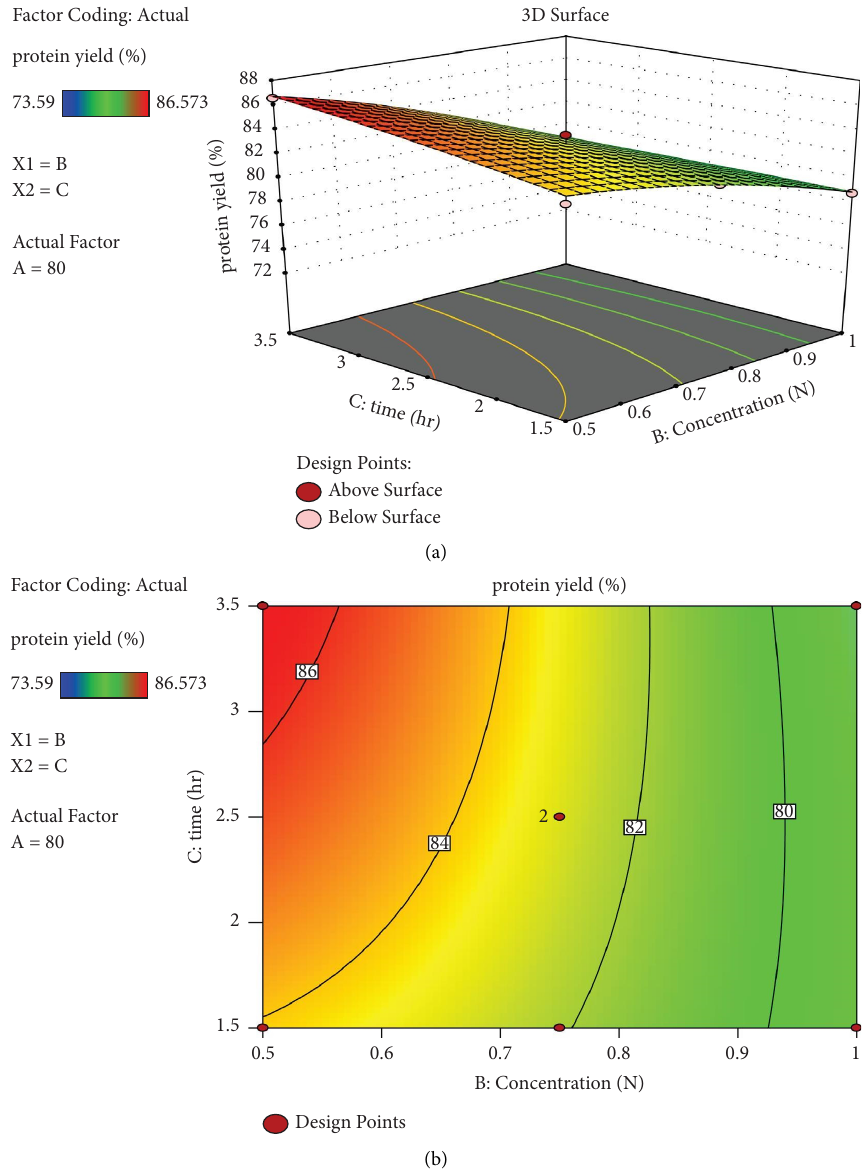
Figure 11: (a) 3D interaction efect time and concentration (b) contour plot interaction efect time and